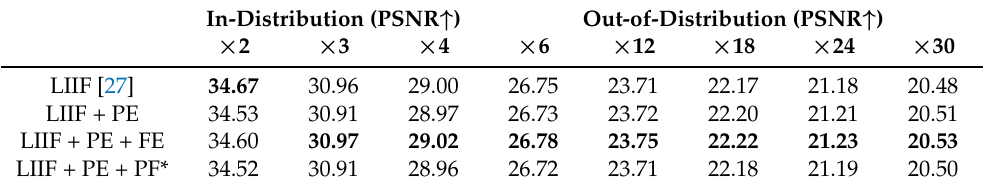
Table 4. Quantitative comparison of the ablation study (PSNR(dB)), the bold in table is the highest value. In-Distribution (PSNR ↑